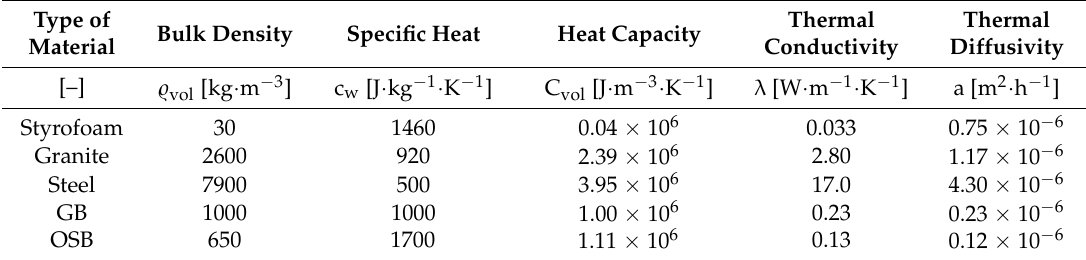
Table 1. Thermal parameters of building materials used in the experiment (values based on various literature sources).